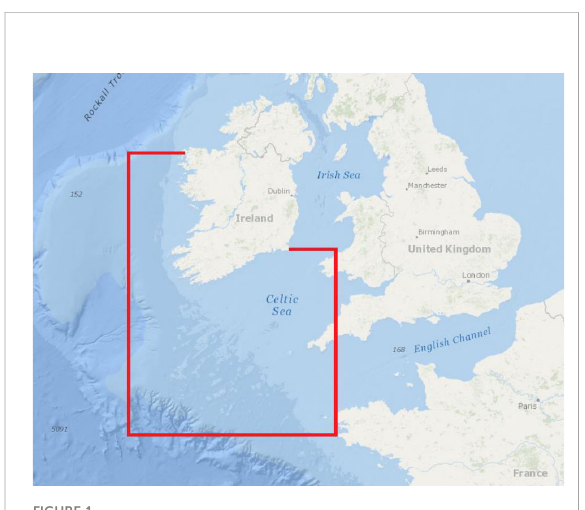
FIGURE 1 Celtic Sea Case Study region. Map from